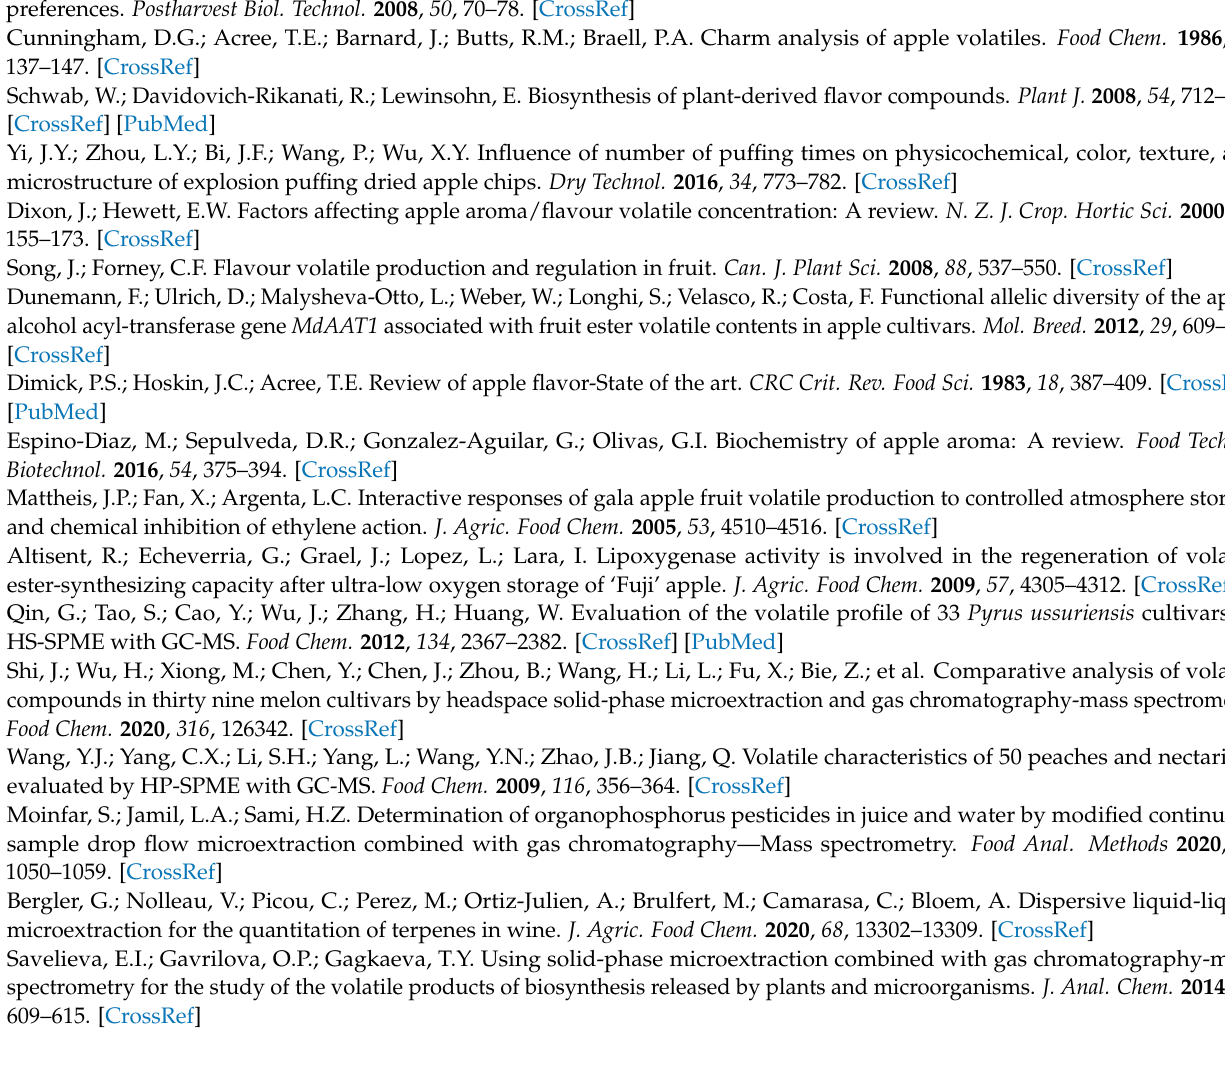
Table S2. The content ( µ g/kg FW) of eight common volatile compounds in peels of 40 apple cultivars. Table S3: The contents ( µ g/kg FW) of identified volatiles in the peels of 40 apple cultivars. Table S4: Percentage (%) of each type of volatiles in apple